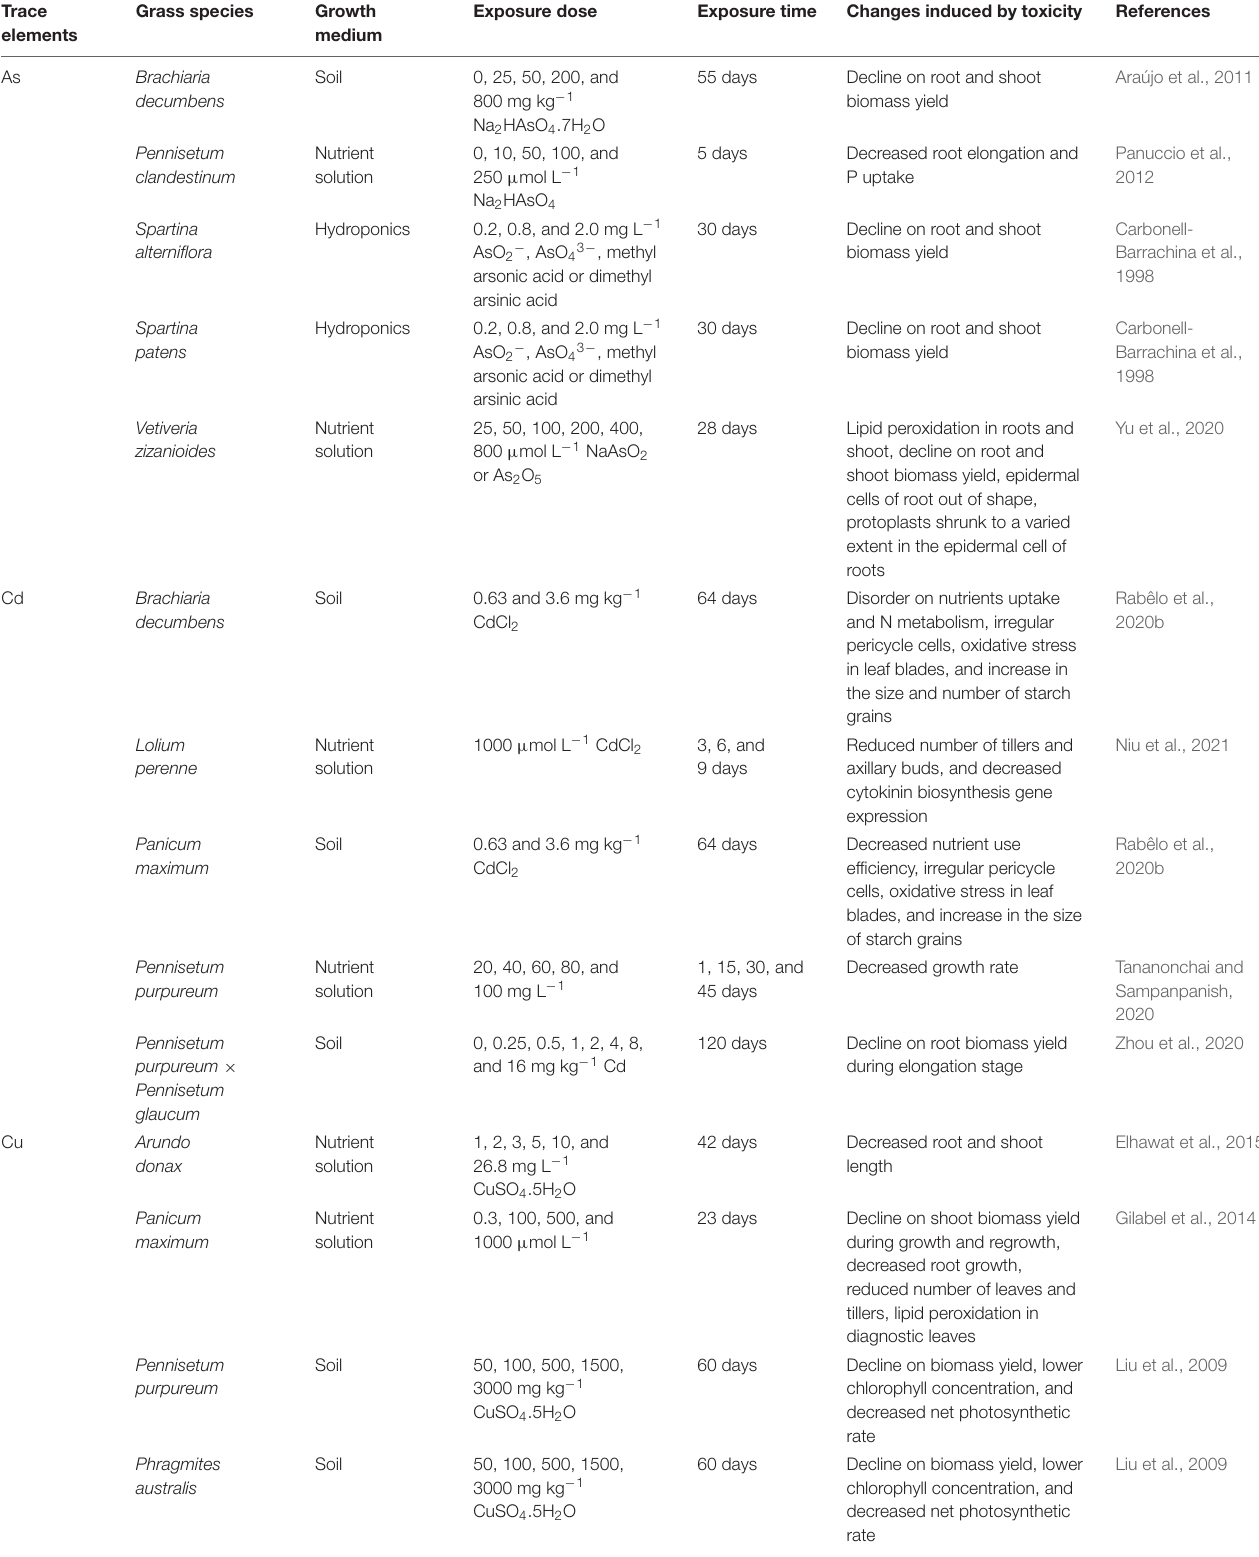
TABLE 1 | Symptoms of toxicity induced by As, Cd, Cu, Ni, or Zn in grasses assessed for phytoremediation. Trace